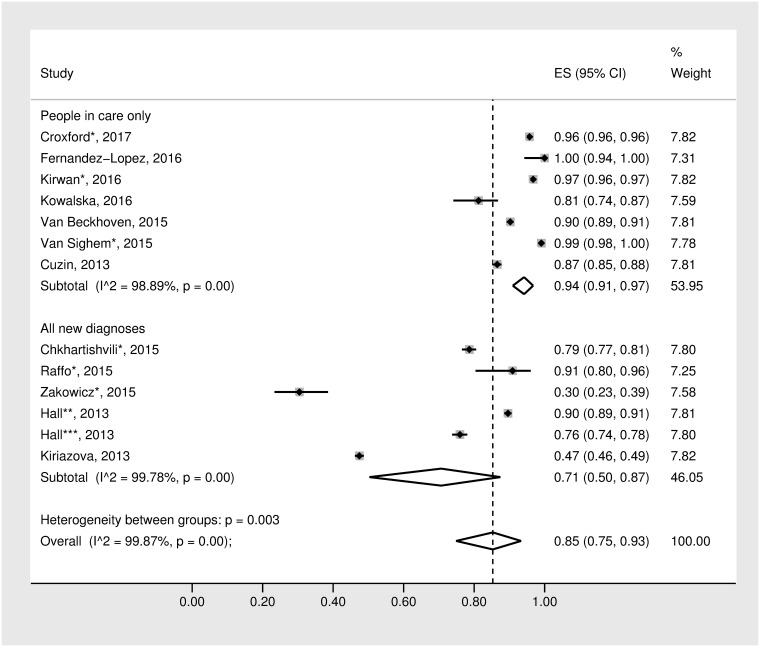
Forest plots for random effects meta-analysis of the proportion of people linked to care within three months of diagnosis by care status.*Conference proceedings or reports; **Hall, 2013—Italy; ***Hall, 2013—Spain.